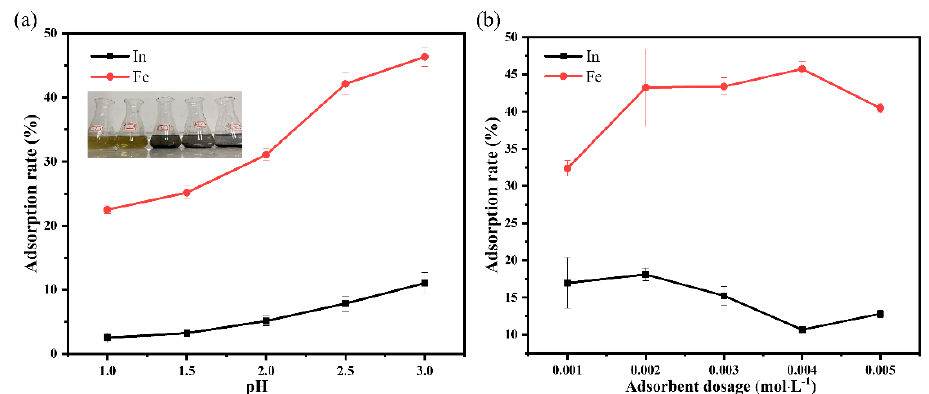
Figure 9. Adsorption rates of EGCG with indium and iron ions in solutions with different ( a ) pH values and ( b ) adsorbent dosages.